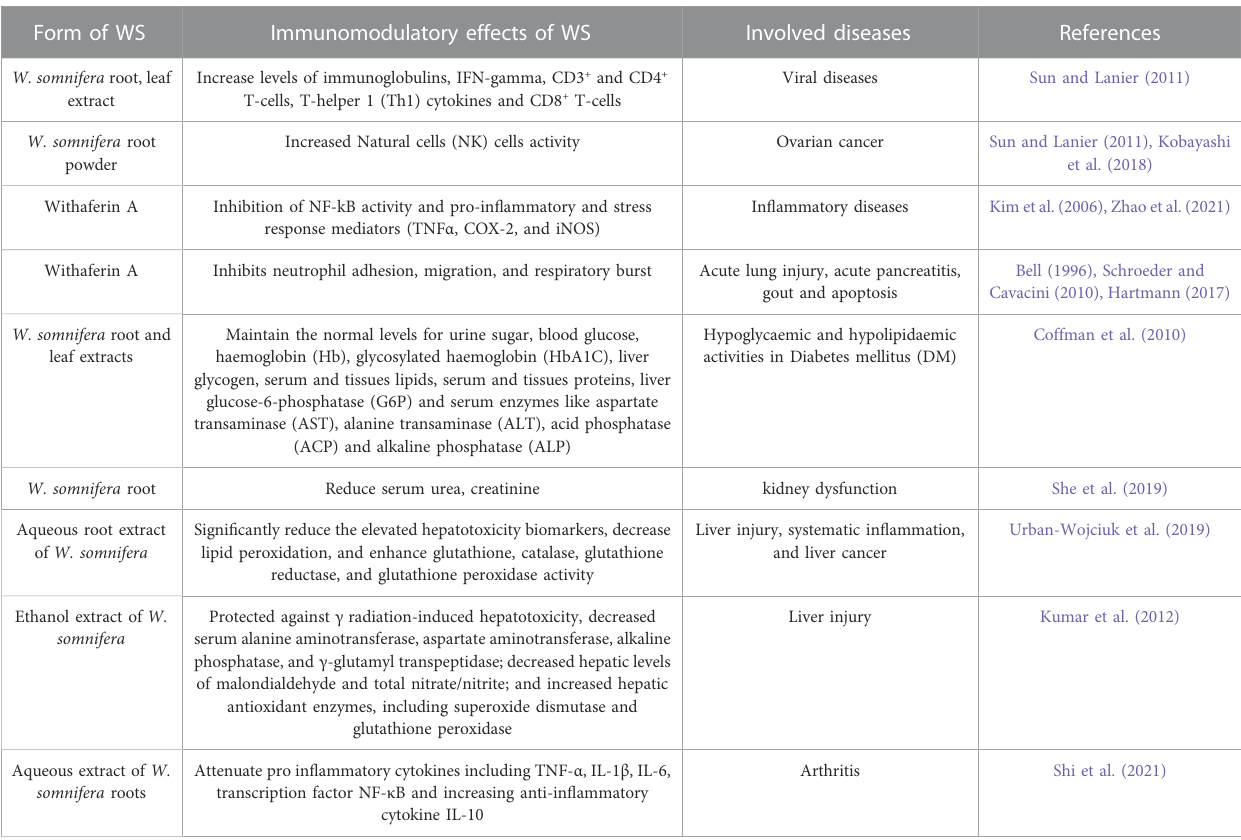
TABLE 1 Immunomodulatory effects of W. somnifera in various